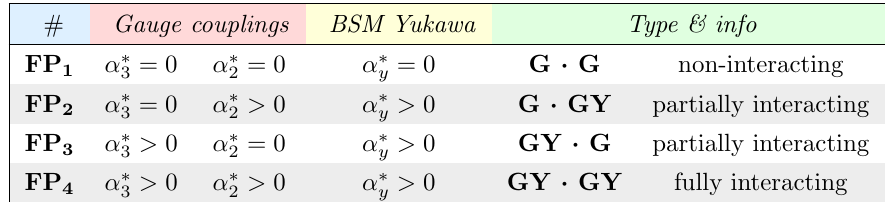
Table 3 . The four di(cid:11)erent types of UV (cid:12)xed points FP 1 {FP 4 in minimal BSM extensions of the SM with (3.7). The primed and unprimed loop coe(cid:14)cients are de(cid:12)ned in appendix A. We also indicate how the (cid:12)xed points can be interpreted as products of the Gaussian (G) and gauge-Yukawa (GY) (cid:12)xed points when viewed from the individual gauge group factors (see main text).